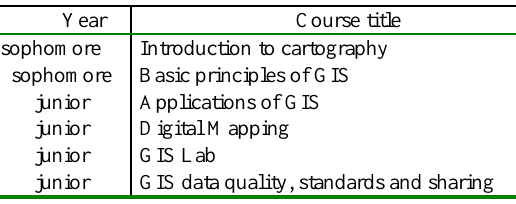
Table 1. GIS-related